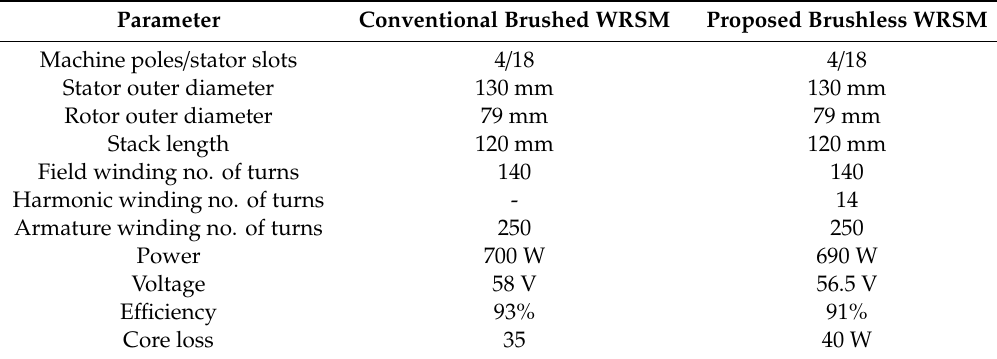
Table 1. Machine parameters. WRSM: wound rotor synchronous machine. Parameter Conventional Brushed WRSM Proposed Brushless WRSM Machine poles / stator slots 4 / 18 4 / 18 Stator outer diameter 130 mm 130 mm Rotor outer diameter 79 mm 79 mm Stack length 120 mm 120 mm Field winding no. of turns 140 140 Harmonic winding no. of turns - 14 Armature winding no. of turns 250 250 Power 700 W 690 W Voltage 58 V 56.5 V E ffi ciency 93% 91% Core loss 35 40